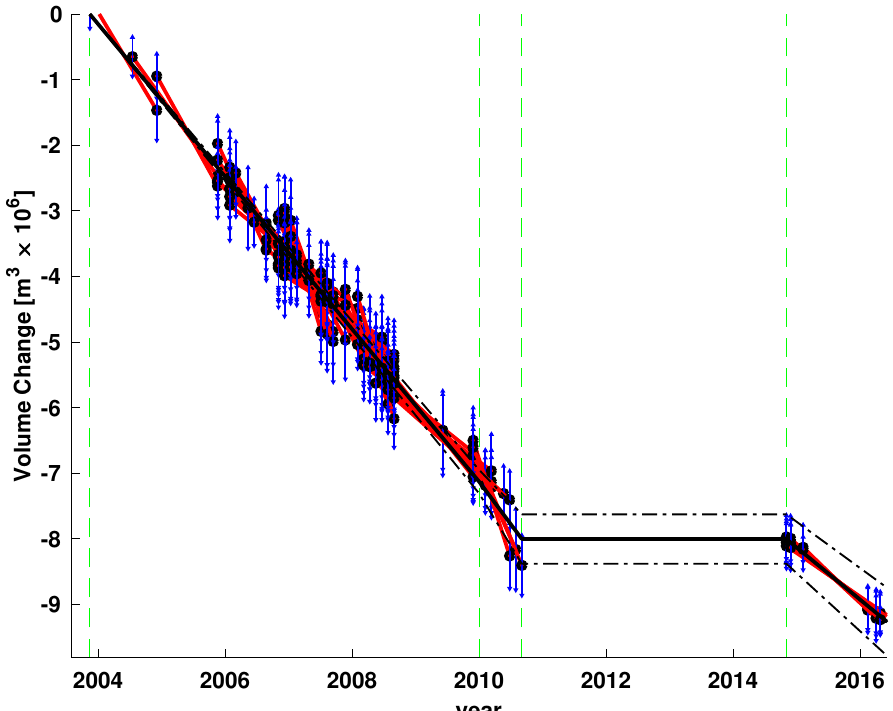
Figure 11. Time series at Coso, showing cumulative volume change in the cuboidal source over time from temporal adjustment of volume change rates estimated from InSAR data spanning 2004 to 2016. Black lines show the modeled volume change with 68% confidence intervals (dashed lines) as estimated by temporal adjustment with a piecewise-linear temporal function [26]. Breaks in the parameterization are shown as green, vertically dashed lines. Red segments indicate measurements of observed volume change derived from individual interferometric pairs, with black circles indicating individual epochs in each pair. For each pair, the volume change at the mid-point of each time interval is plotted to fall on the modeled curve and the vertical blue bars denote 1 σ measurement uncertainty, after scaling by the square root of the variance scale factor. Table 4. Results from two-tailed Student’s t-test with degrees of freedom dof at the 95% confidence level (e.g., [37], p. 524) for volume change rates estimated from interferometric synthetic aperture radar (InSAR) data. H 0 : equal rates; H 1 : rates differ. Start